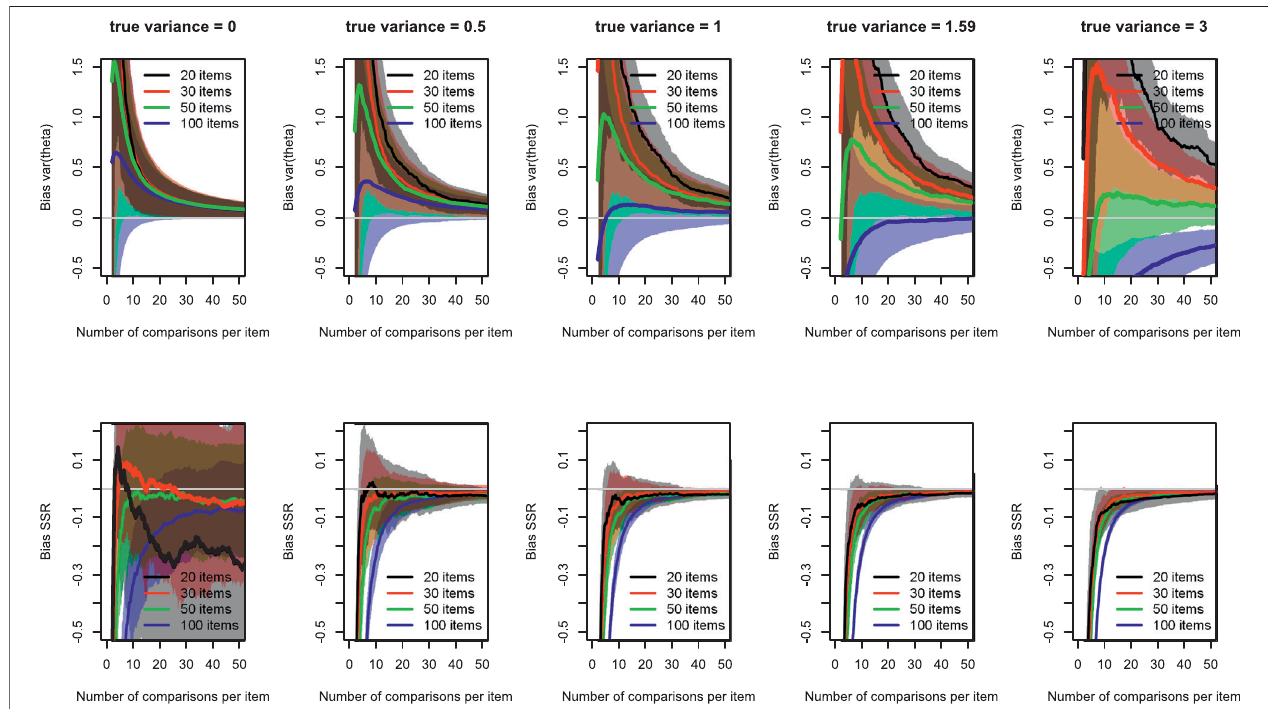
(cid:2) ) FIGURE 2 | Development of bias in S 2 ( θ and bias in SSR with increasing numbers of comparisons per item averaged across simulations with 68% con fi dence intervalsforalltruevarianceconditionsandallnumbersofitems.BiasinSSRwascomputedas SSR — benchmarkreliability .For S 2 ( θ